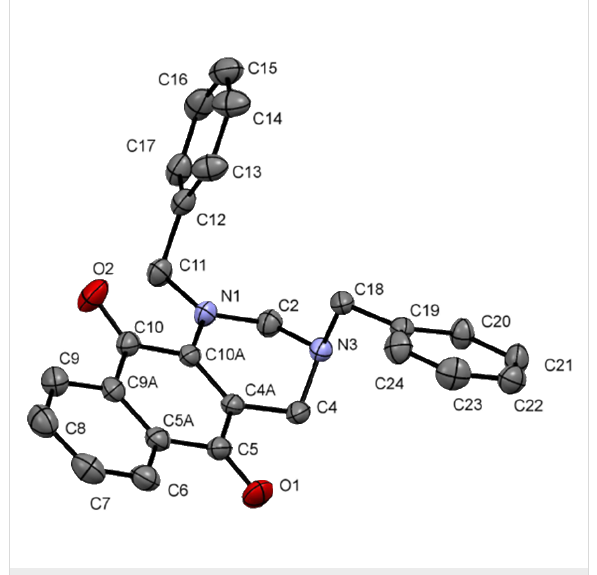
Figure 3: ORTEP diagram of compound 23 depicted with ellipsoids drawn at the 50% probability level and the atom-numbering